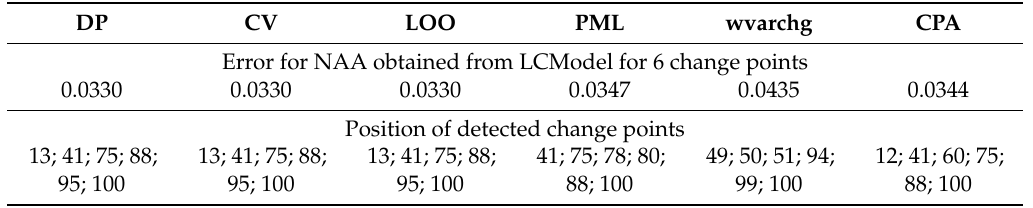
Table 3. The error values (computed using Equation (4)) obtained from the NAA TRA,REC levels series analysis for a predefined number of six change points. The time points correspond to the following dates of the measurements: 13—19 October 2006, 41—30 October 2007, 75—19 December